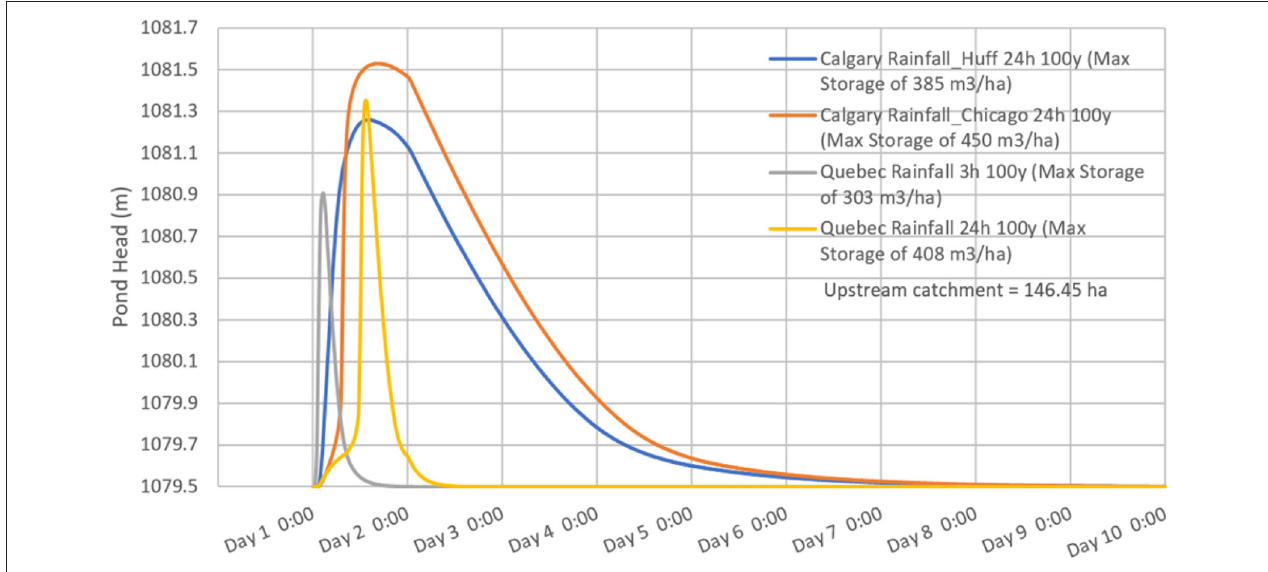
FIGURE 11 | Comparison of Water Levels in Storm Pond—Calgary vs. Quebec